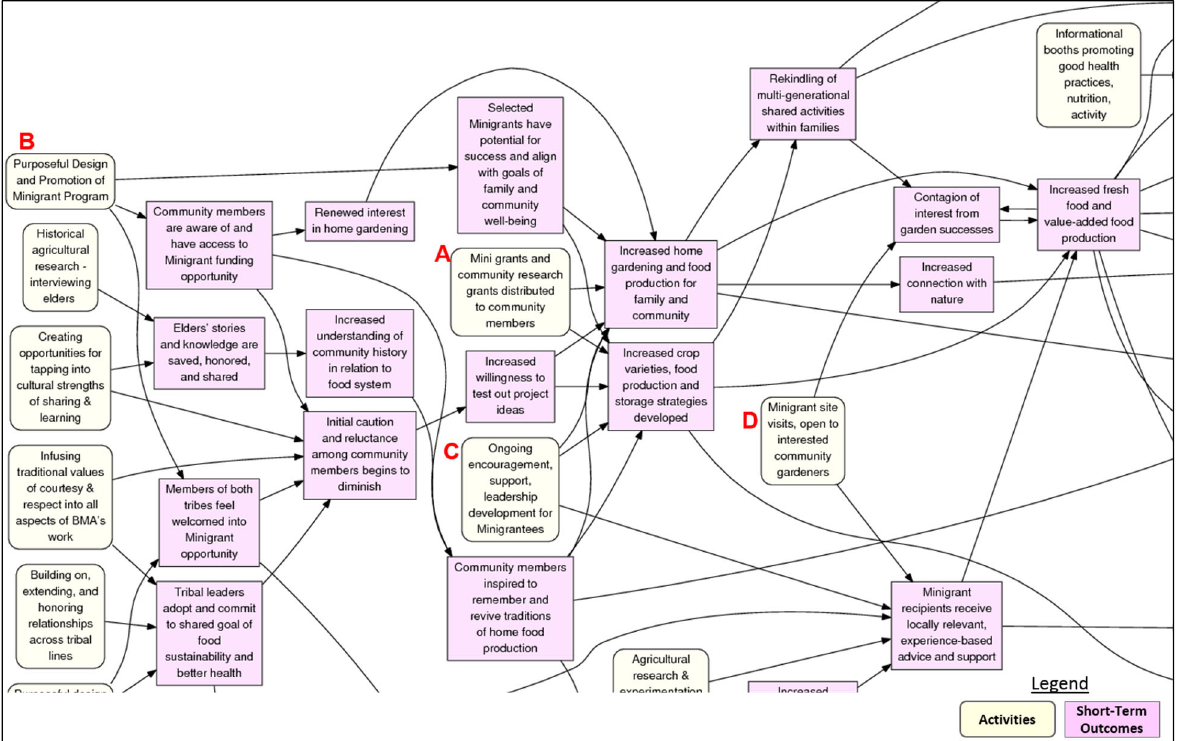
Figure A1. Subsection of Blue Mountain Associates (BMA)’s Collaborative Pathway Model Relating to